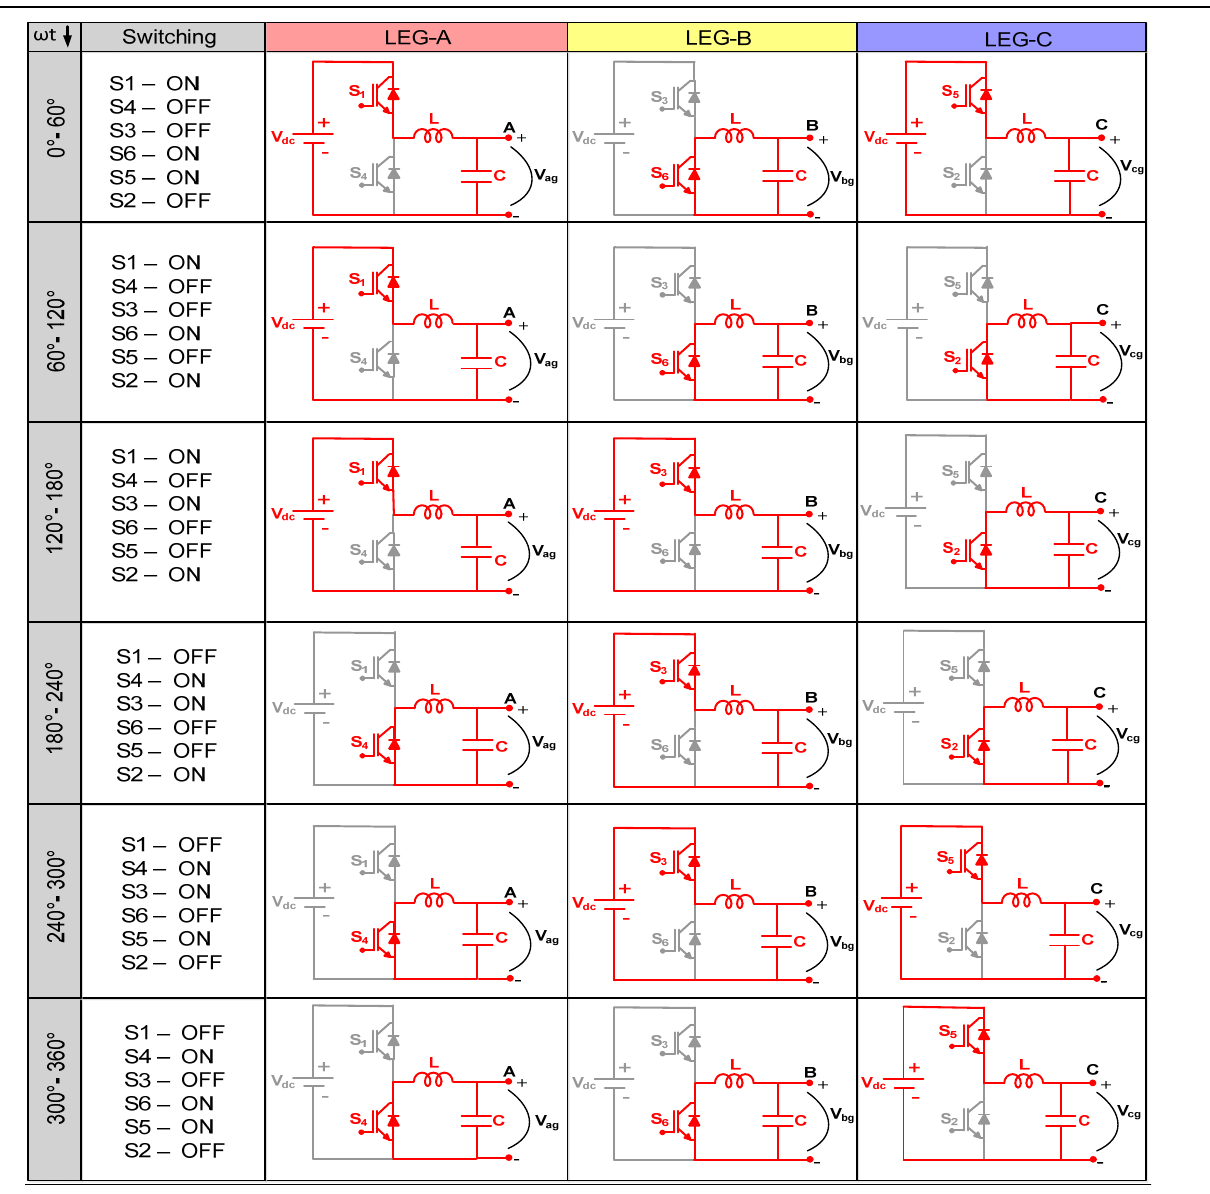
Table 1. Switching states for operation of